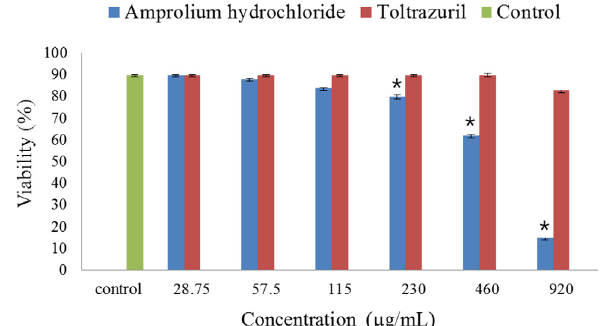
Figure 4. Viability of Kudoa septempunctata spores treated with different concentrations of amprolium hydrochloride and toltrazuril for 48 h as determined by fluorescent dye stains. Untreated spores were the negative control. Data are mean ± standard deviation. *Value shows significant difference from the control ( p <